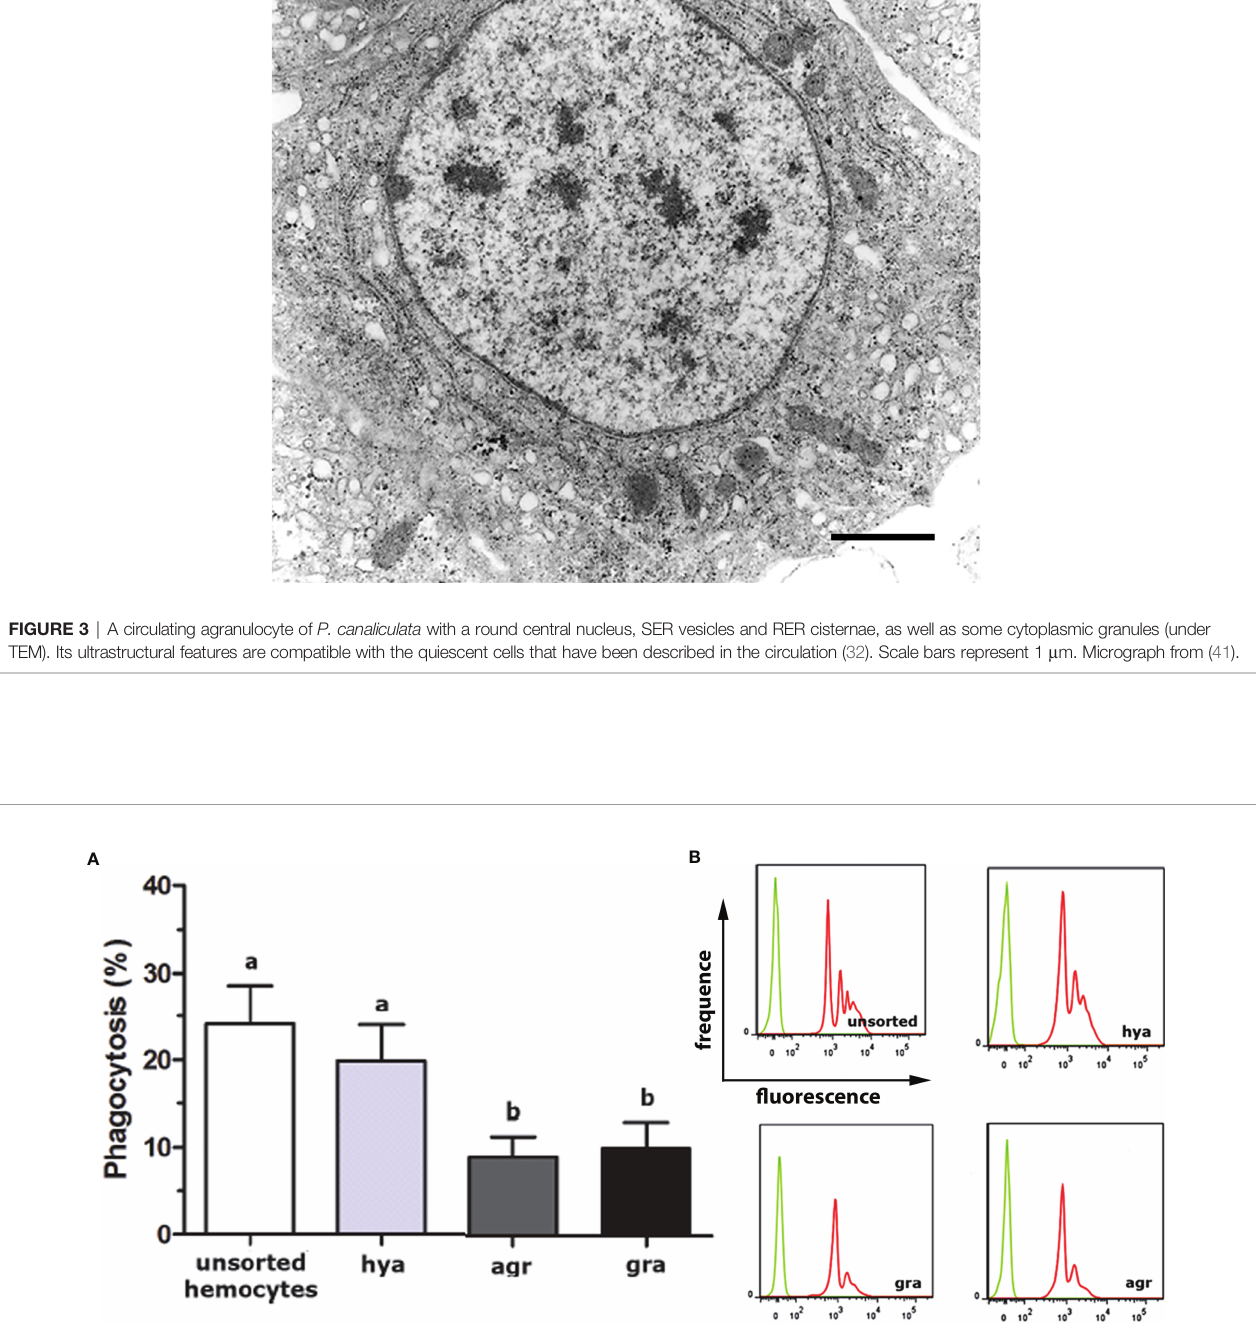
FIGURE 4 | In vitro phagocytosis of fl uorescent beads by unsorted hemocytes of P. canaliculata and by sorted circulating hyalinocytes, agranulocytes and granulocytes. (A) Phagocytosis index of unsorted and sorted circulating hemocytes (means ± SEM; N = 6; different letters indicate statistically signi fi cant differences, one-way ANOVA, Tukey test). (B) Histograms showing the distribution of phagocytic (red) and non-phagocytic (green) hemocytes. Fluorescence peaks correspond to hemocyte subpopulations with different numbers of phagocytized fl uorescent beads. GR, agranulocytes; GRA, granulocytes; HYA, hyalinocytes. From